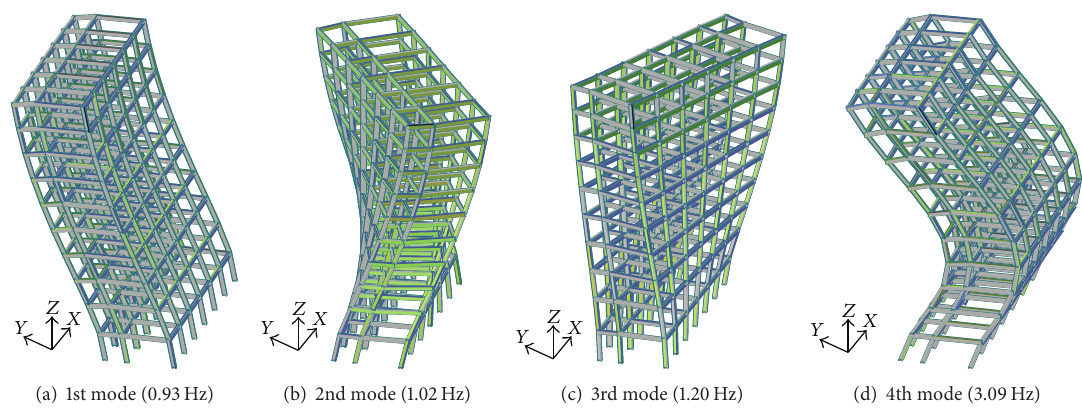
Figure 6: Mode shapes of the example building.